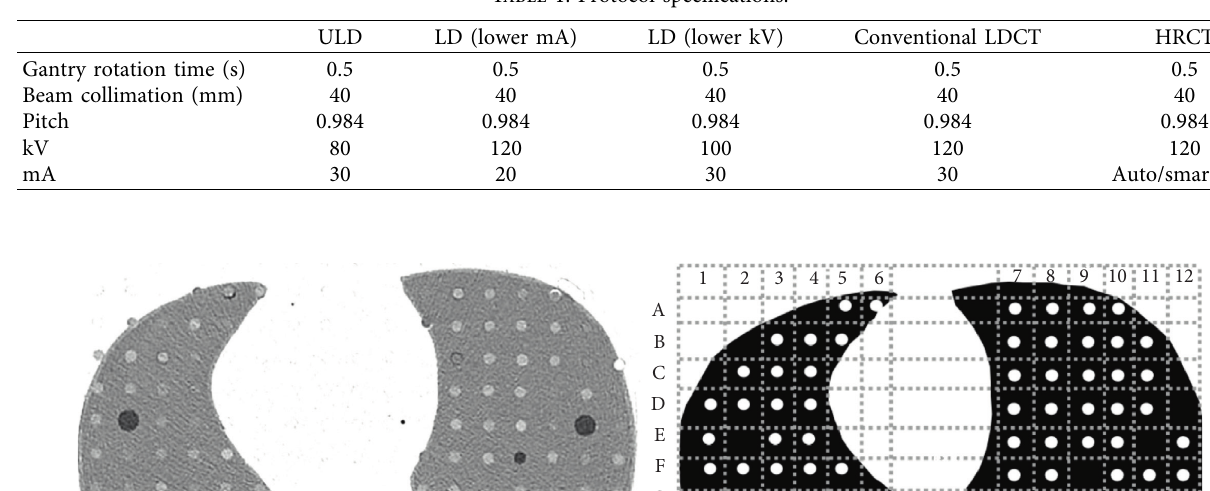
Table 1: Protocol specifications.